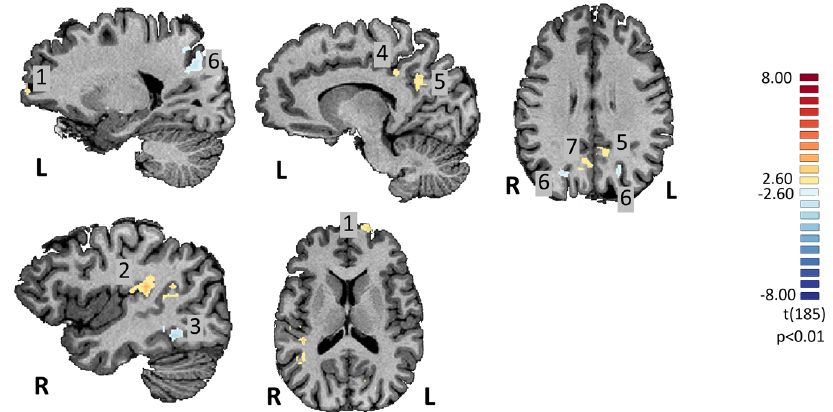
Fig. 1 Whole-brain BOLD activation map. Statistical BOLD map depicting all ROIs obtained from the contrast Scrambled AD>Scrambled Controls. Legend: 1 = left prefrontal cortex; 2 = right posterior insula; 3 = right fusiform gyrus; 4 = left ventral posterior cingulate gyrus; 5 = left posterior cingulate cortex; 6 = right/left parietal region (BA7) (deactivation ROI); 7 = right parietal region (BA7). ROI 5 depicts the PCC (posterior cingulate cortex), as it is the region under